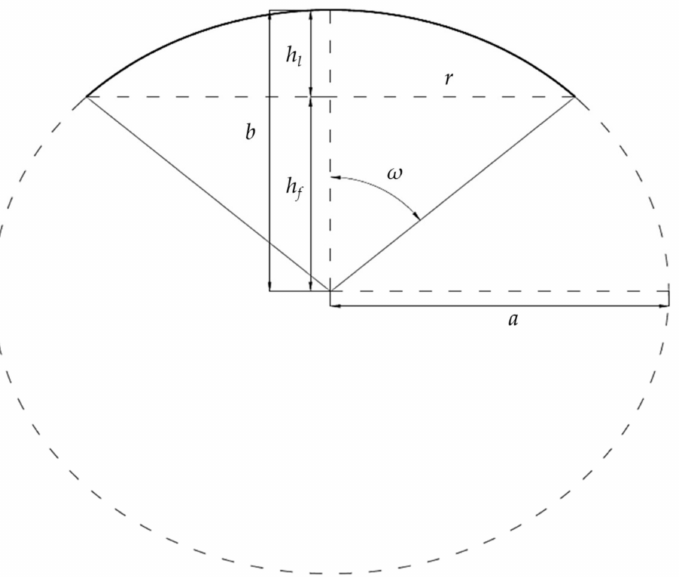
Figure 2. Segment of an ellipse used as an outline for ESFL. “ a ” and “ b ” are the major and minor axis of the ellipse. “ b ” is the sum of the height of the arch ( h l ) and the focal length ( h f ) and ω is the rim angle of the Fresnel lens.